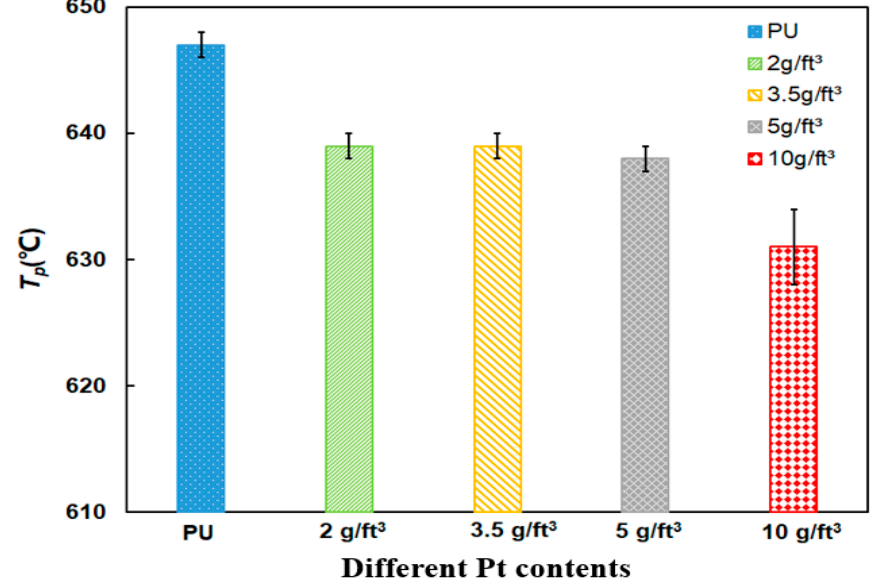
Figure 7. Comparison of T p of PU/Pt mixtures at different contents of Pt.